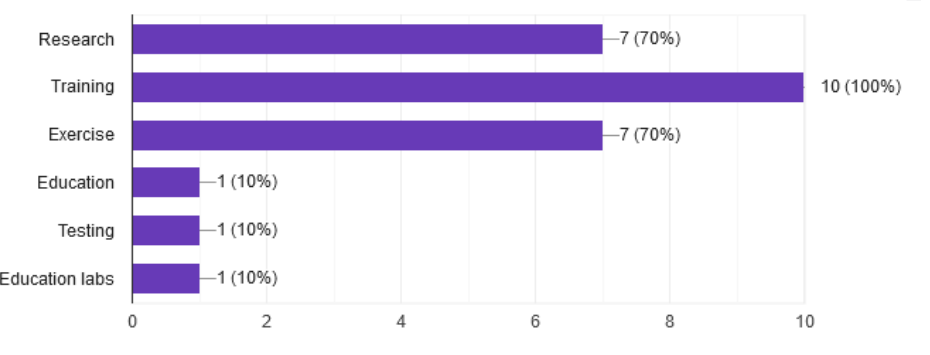
Figure 1. Objectives of the Cyber